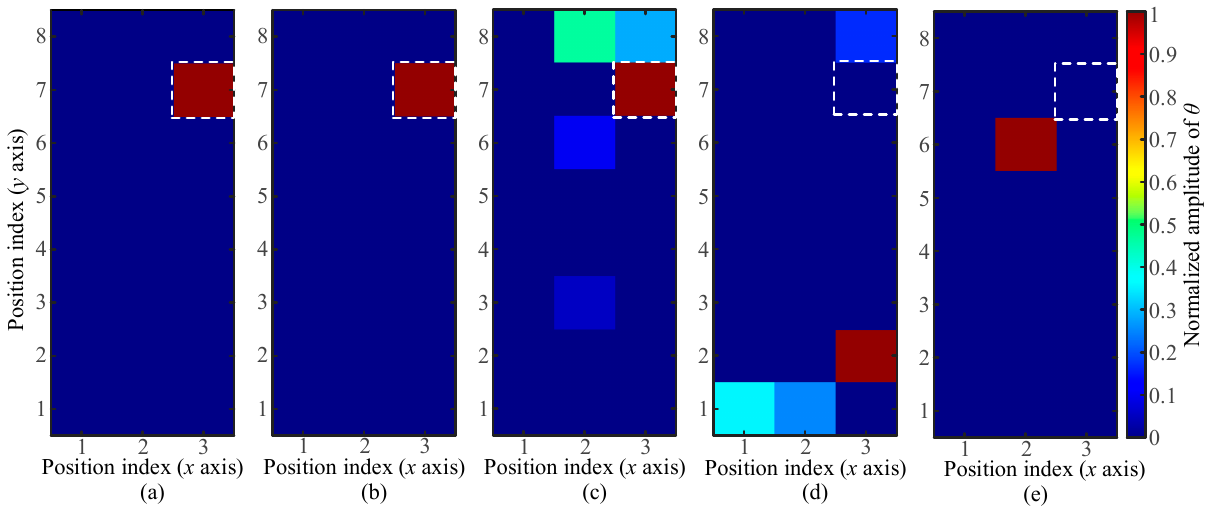
Figure 6. Adaptability of the LWT to an unknown touch of different touch forces: ( a – e ) localization results of a touch action at the pixel ( x = 3, y = 7) with a touch force of F t = 2 N, F t = 1.6 N, F t = 1.2 N, F t = 0.8 N, and F t = 0.4 N, respectively.